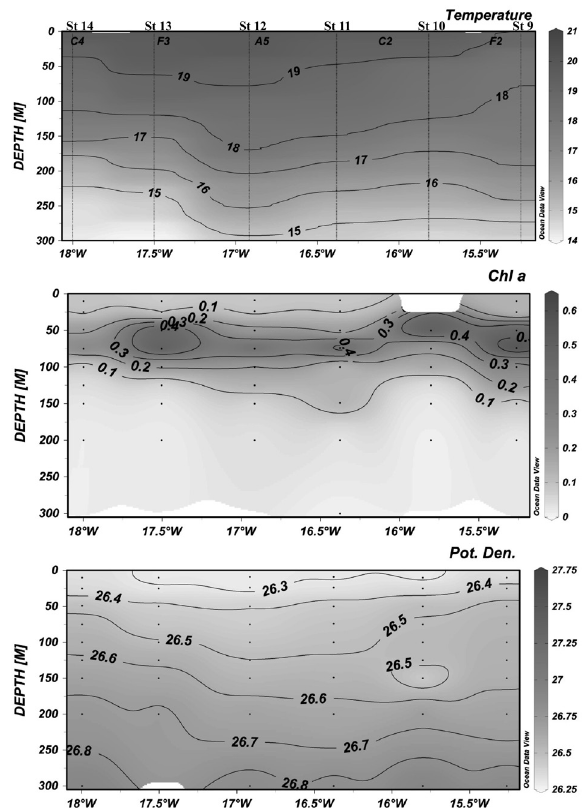
Fig . 3. – Temperature (ºC), chlorophyll a (mg m -3 ) and potential density (kg m -3 ) vertical profiles in the first 300 m (250 m for Chl a ) along line 1 at 27ºN.